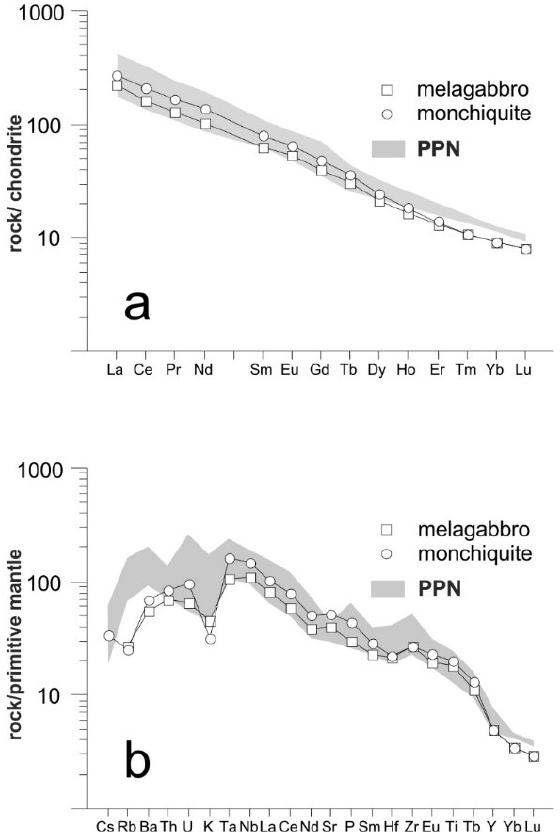
Figure 3. REE patterns ( a ) and multi-element spider diagram ( b ) of the San Giovanni in Pane and Punta delle Pietre Nere (PPN) rocks. Normalizing values are from McDonough and Sun [48] and Sun and McDonough [49] in (a) and (b), respectively. Patterns of PPN rocks (in gray) from analyses by De Astis et al. [35] and Avanzinelli et al. [50]. Table 1. Major oxide contents and CIPW normative composition of the melagabbro and monchiquite samples from San Giovanni in Pane. For norm calculation it was assumed a Fe 3+ /(Fe 3+ + Fe 2+ ) ratio of 0.30.